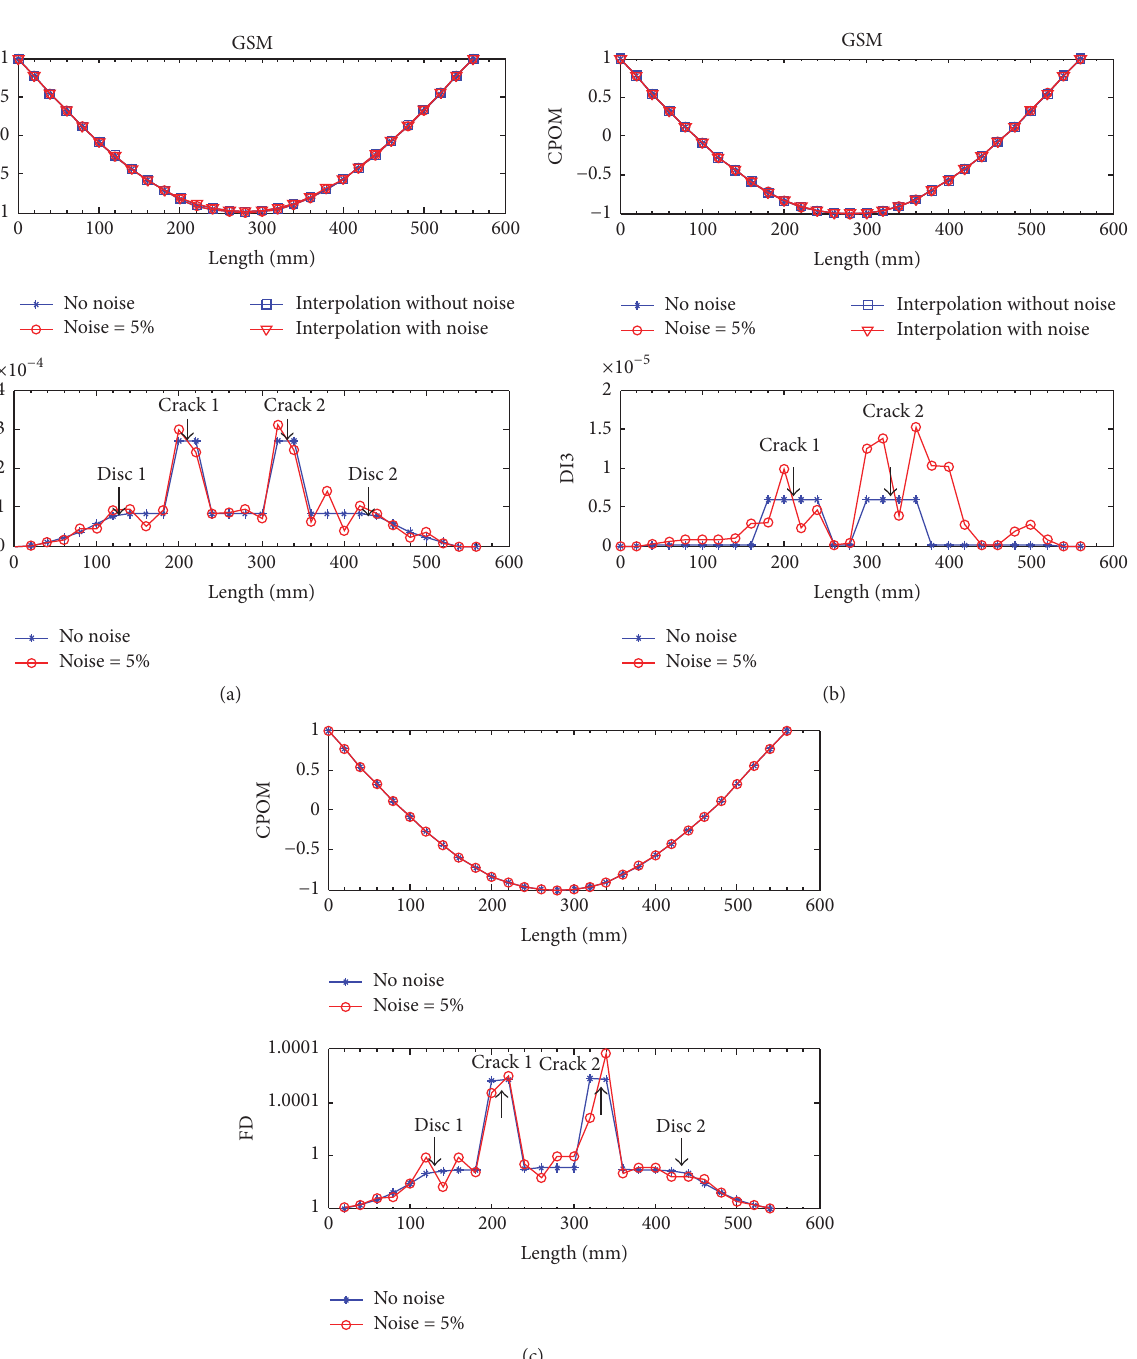
Figure 8: Localization results of double-cracked rotor in case 1. (a) Localization using GSM by linear gapped interpolation. (b) Localization using GSM by cubic gapped interpolation. (c) Localization using